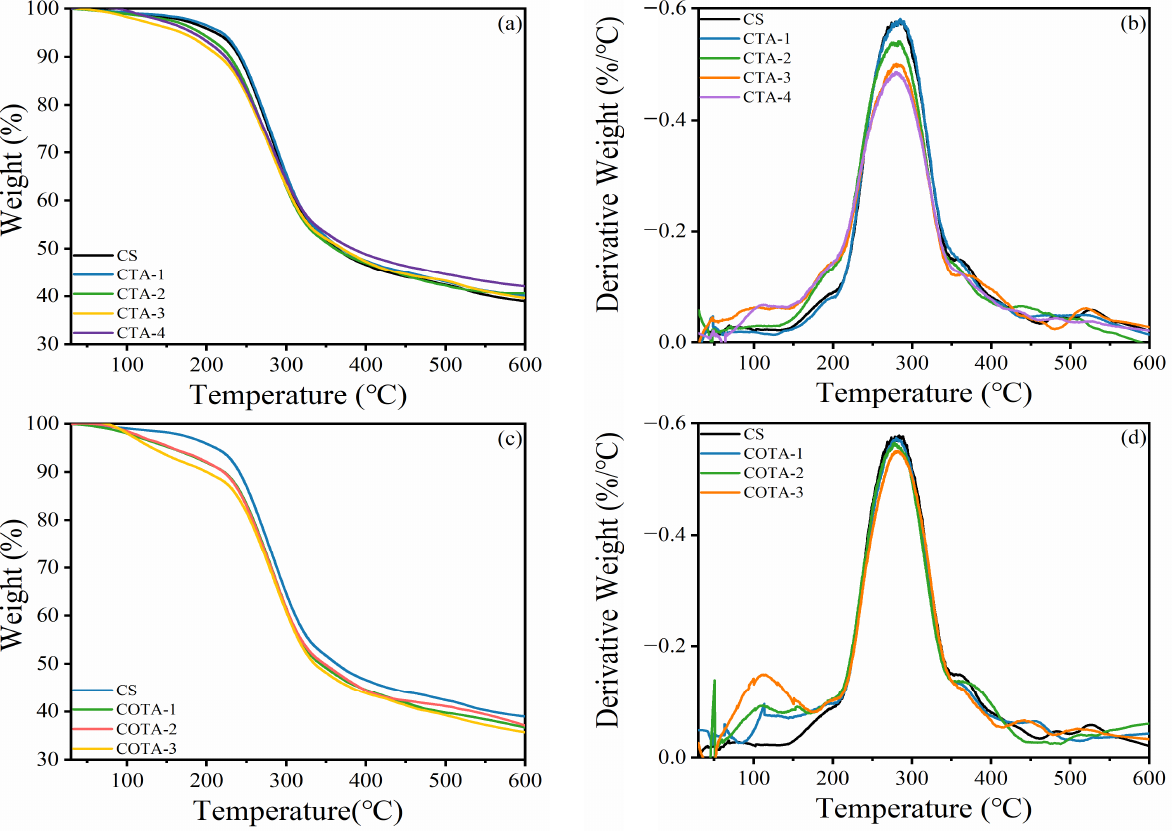
Figure 6. ( a , b ) TGA and DTG curves for CS and CTA films; ( c , d ) TGA and DTG curves for CS and COTA films. Table 1. Thermal degradation parameters for CS, OTA, and COTA films with different propor ‐ tions.